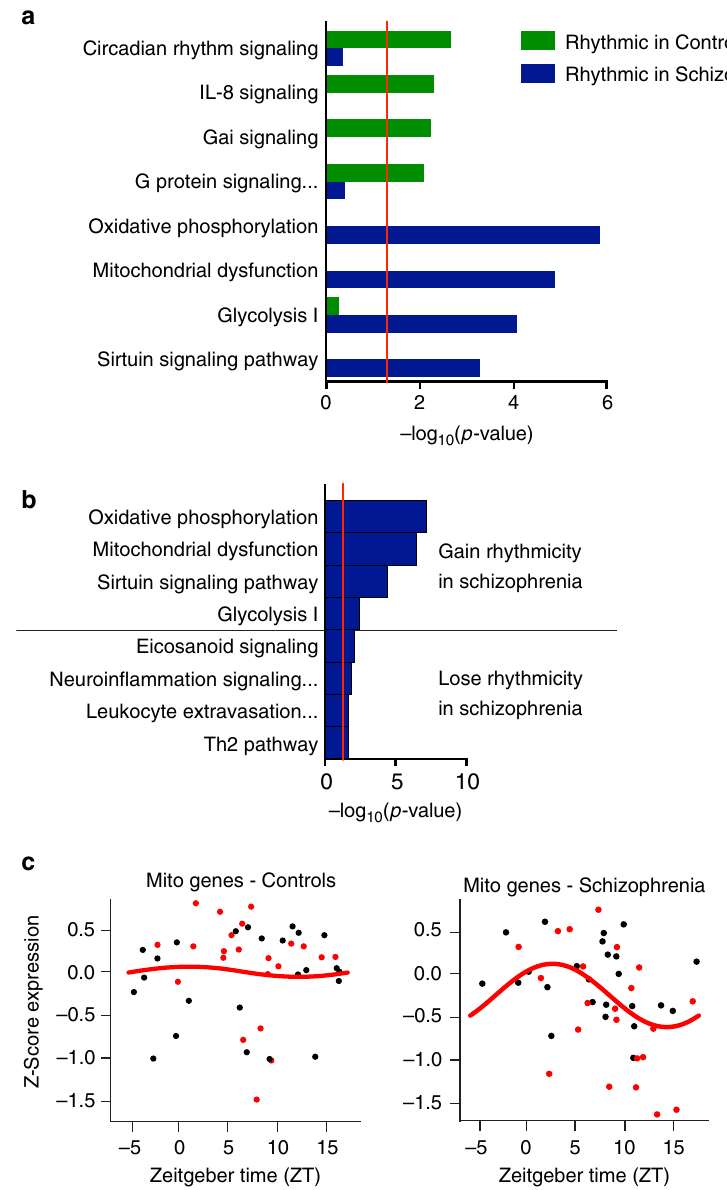
Fig. 4 The top pathways represented by the rhythmic genes in control subjects and subjects with schizophrenia are completely distinct. While the top pathway in healthy controls relates to circadian rhythm signaling ( a ), the top pathways in subjects with schizophrenia relate to oxidative phosphorylation and mitochondrial dysfunction. b The top pathways for genes that gain rhythmicity in schizophrenia compared to healthy controls are oxidative phosphorylation and mitochondrial dysfunction. c Expression of mitochondrial-related genes in control (left) and subjects with schizophrenia (right). Expression for each gene was Z-transformed and averaged to create a Z-mitochondria (Z-mito) score for each subject. These Z-mito values are plotted across time of day. These mitochondrial-related genes are not rhythmic in healthy controls. In subjects with schizophrenia, mitochondrial-related genes peak between ZT 0 –